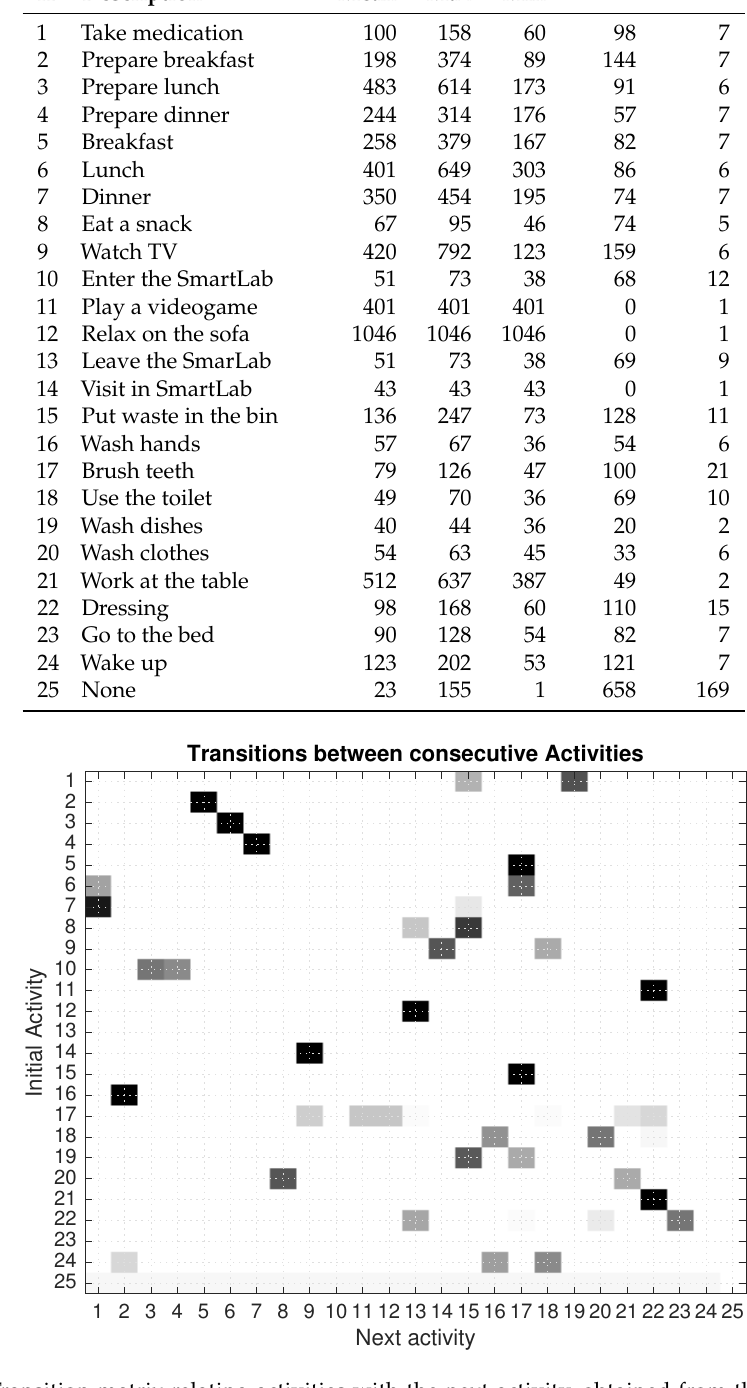
Figure 1. Transition matrix relating activities with the next activity, obtained from the seven days training